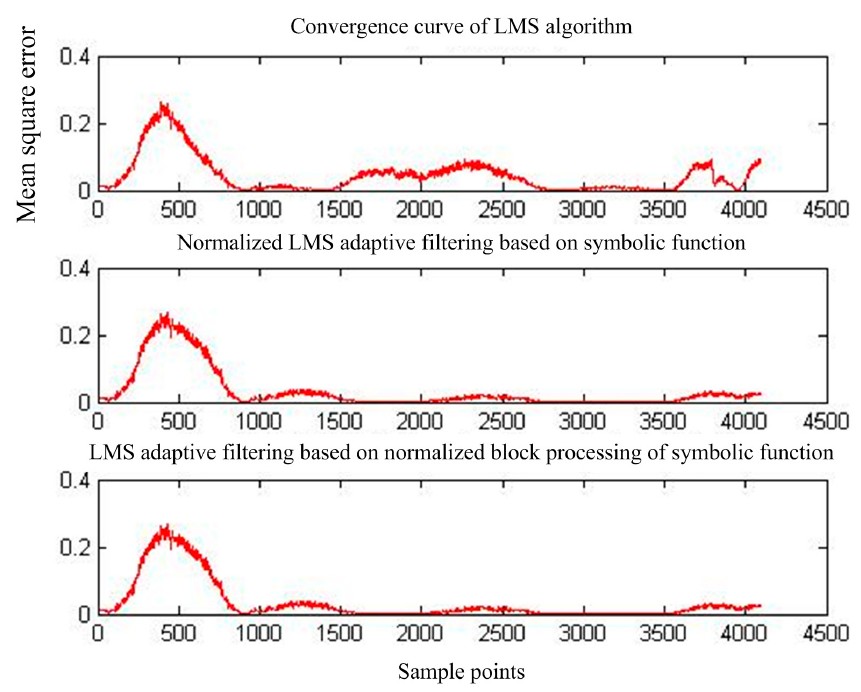
Figure 20. Mean square error convergence of the three adaptive interference cancellation algorithms.